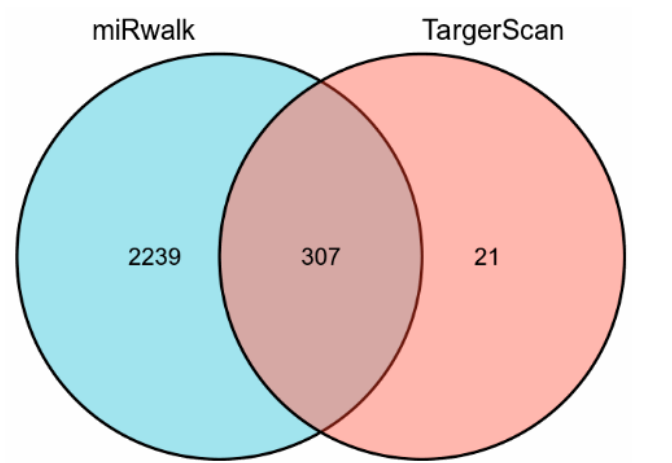
Figure 1. The study scheme.